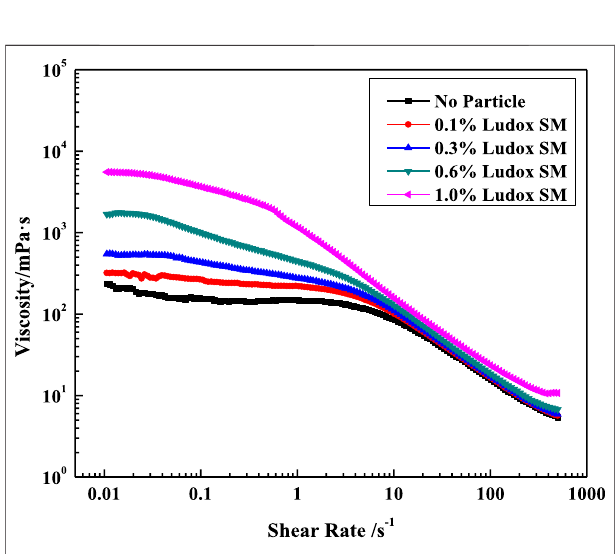
FIGURE 12 | Effect of SiO 2 concentration on the modulus at different frequencies. ( w (LBA + SDS) (cid:2) 0.8%, LBA:SDS (cid:2) 3:1, T (cid:2) 50 ° C, w (NaCl) (cid:2) 4%, shear stress (cid:2)